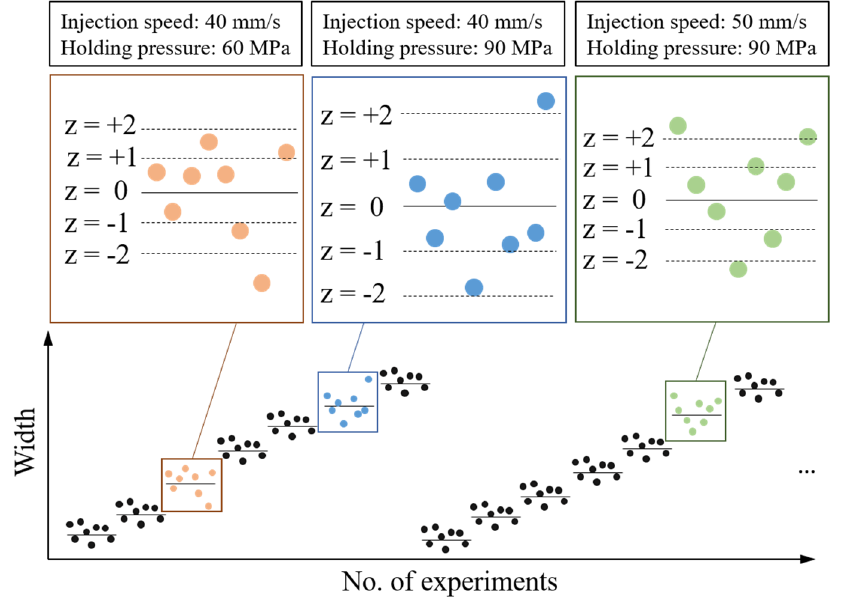
Figure 1. Example of z-score outlier filtering.